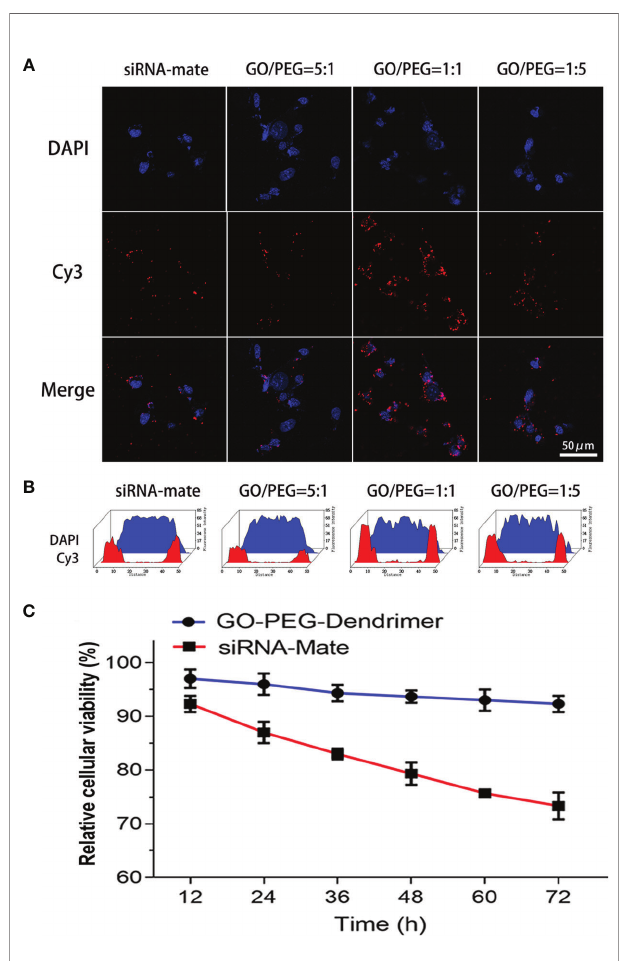
FIGURE 3 | Transfection ef fi ciency and cytotoxicity of the GO-PEG- dendrimer. Both the immuno fl uorescence staining (A) and fl uorescence intensity quanti fi cation (B) results show that among the three GO-PEG- dendrimer structures with different GO/PEG ratios, the structure with a GO/ PEG ratio of 1:1 had the highest transfection ef fi ciency and was more ef fi cient than the commonly used transfection reagent siRNA-Mate. The other two structures with GO/PEG ratios of 5:1 and 1:5 had transfection ef fi ciencies that were similar to that of the siRNA-Mate. The CCK-8 assay (C) showed that the GO-PEG-dendrimer was much less cytotoxic than siRNA-Mate during the 72 h of coculture with SK-N-SH